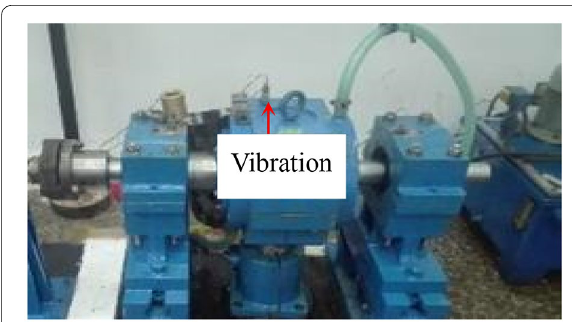
Figure 5 Schematic of tested bearing part of the test platform and sensors installation